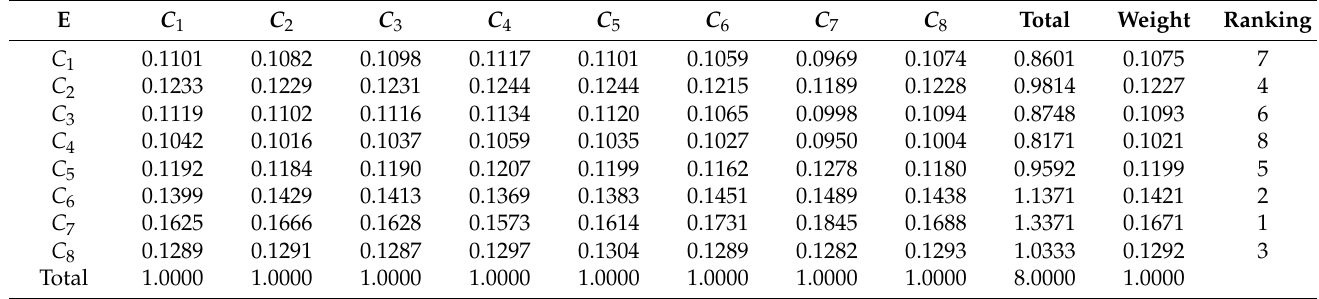
Table 7. Normalized matrix of priority weight and rank of influential